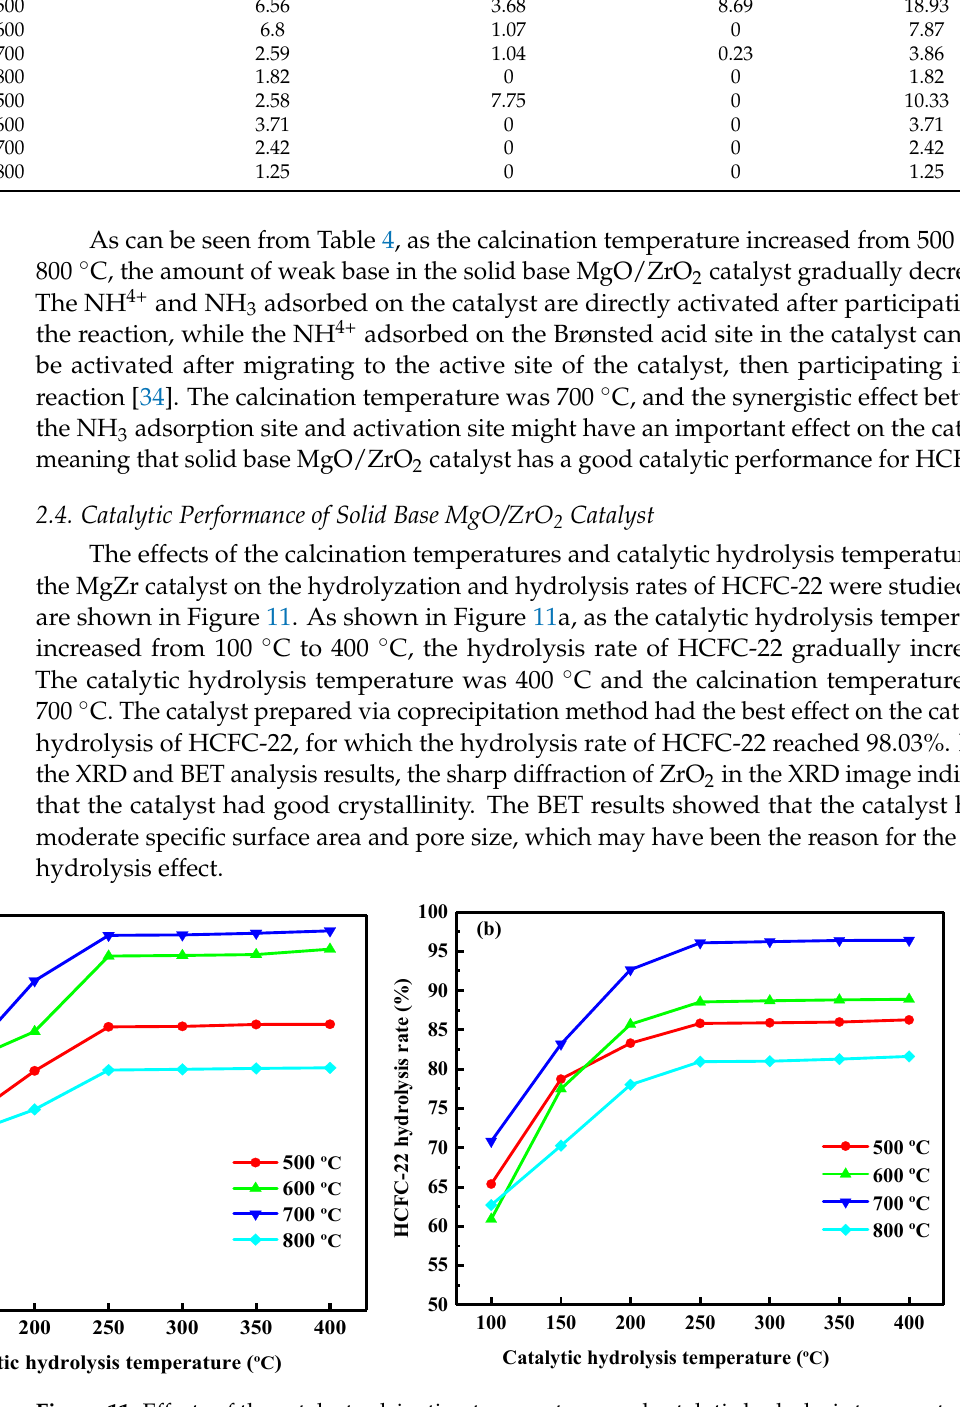
Figure 11. Effects of the catalyst calcination temperatures and catalytic hydrolysis temperatures on the hydrolyzation and hydrolysis rates of HCFC-22 samples formed by ( a ) coprecipitation method and ( b ) impregnation method.